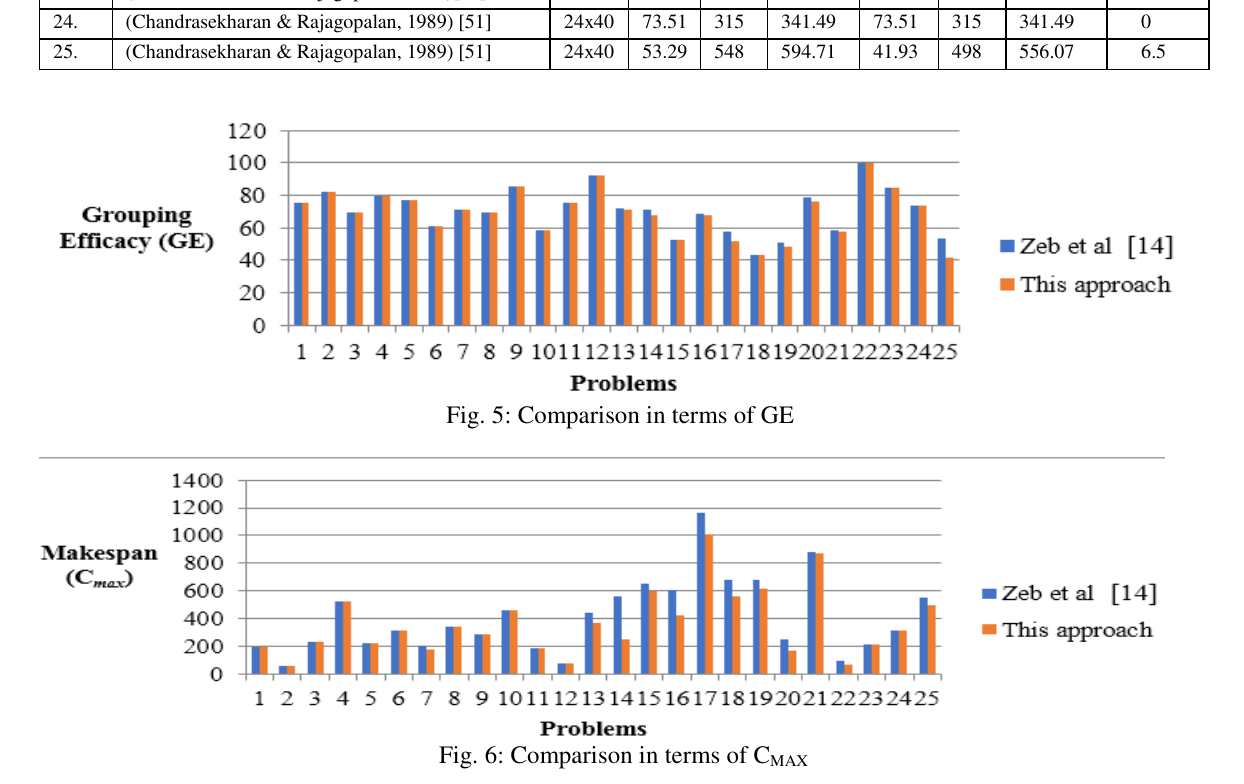
Fig. 6: Comparison in terms of C MAX